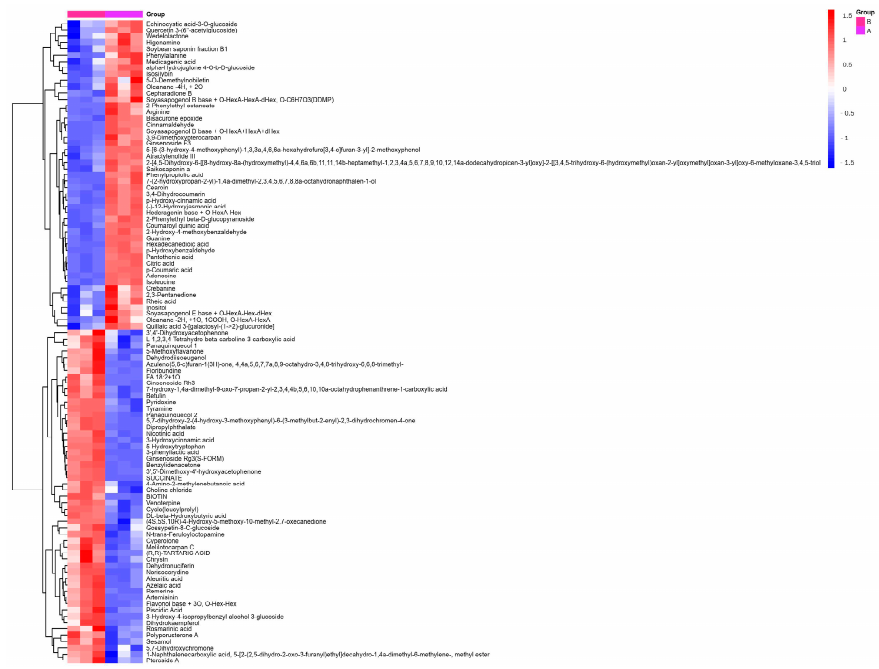
Figure 4. Hierarchical Cluster Analysis Heatmap of SHLF (Group B) to SHL (Group A).